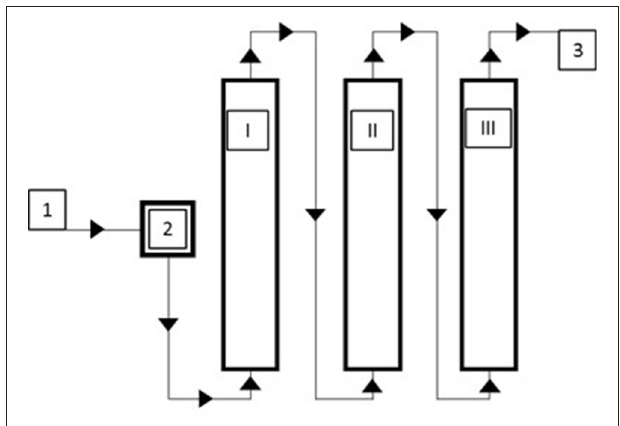
FIGURE 1 | Scheme of the adsorption module for dynamic sorption studies 1/3–inflow/outflow, 2–pressure regulator and flowmeter, I–III–adsorption